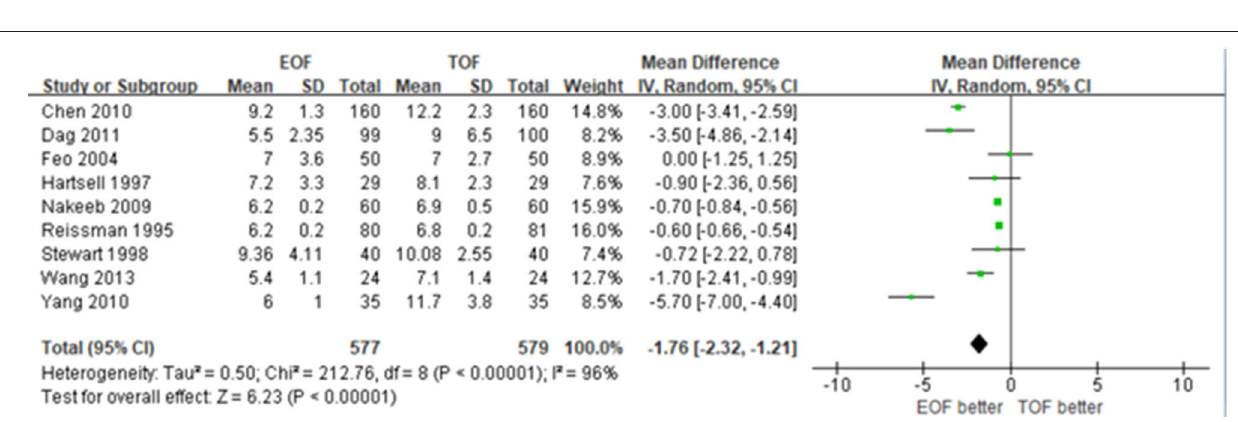
FIGURE 4 | Forest plots of length of hospital